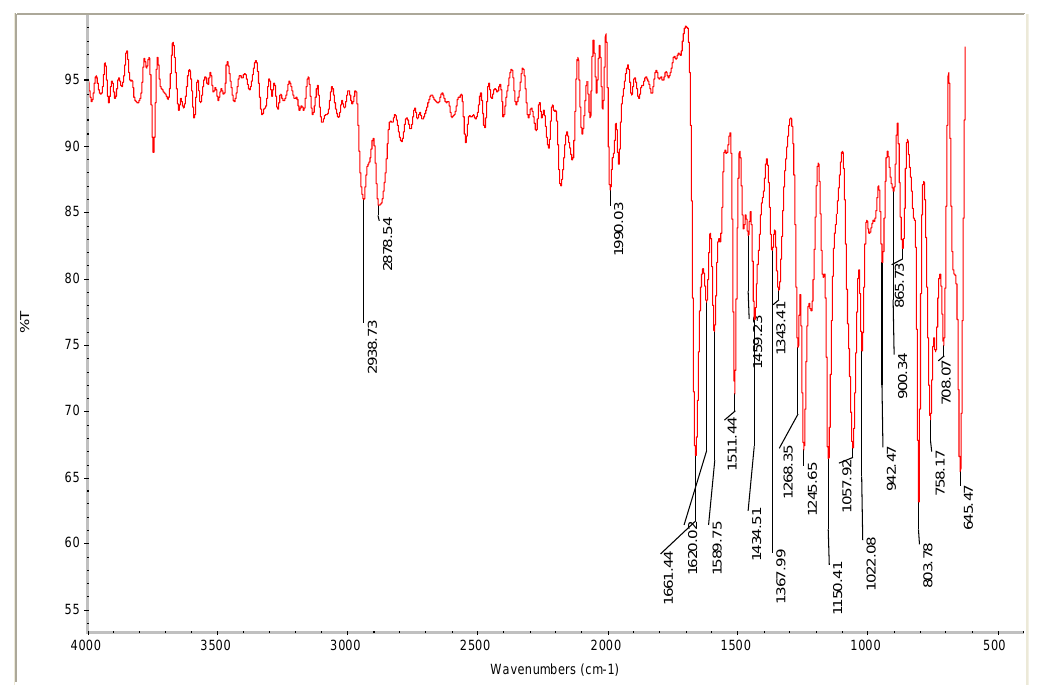
Figure S3: FT-IR spectrum of dialdehyde monomer m -HOB